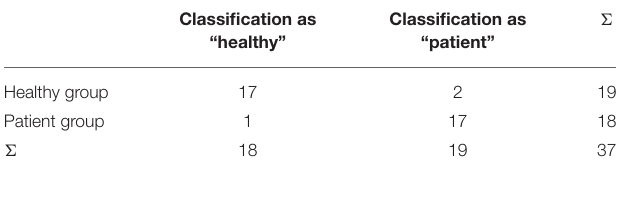
TABLE 2 | Contingency table for CNN classification in 2 classes.